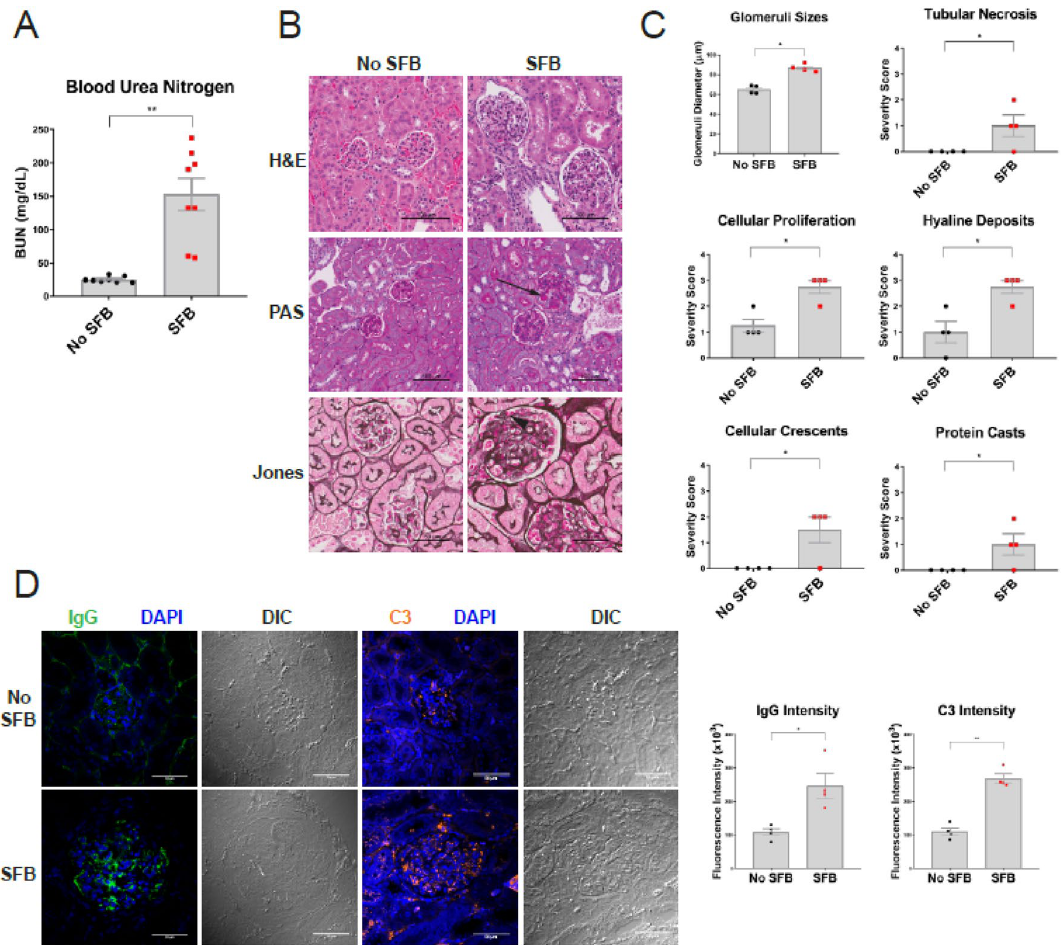
Figure 1. NZM2410 colonized with SFB exhibit intensified kidney disease with elevated immune-complex deposition. 10-week old mice were oral gavaged with fecal matter from mice harboring SFB or control mice and sacrificed at 30-weeks of age and subjected to biochemical analysis. ( A ) Serum blood urea nitrogen (BUN). ( B ) Kidney disease was directly assessed by performing hematoxylin & eosin (H&E), periodic acid-Schiff (PAS) and Jones’ silver stains. H&E, PAS and silver stain highlight enlarged glomeruli, hyaline deposits (black arrow) and subendothelial deposits (black arrowhead) in SFB colonized mice, respectively. ( C ) Histopathological assessment of kidney tissue was blindly scored by a veterinary pathologist; kidney pathology was defined as tubular necrosis, cellular proliferation, hyaline deposits, cellular crescents and protein casts. ( D ) Immunofluorescence staining of IgG and C3 deposition in the glomerular and tubulointerstitium of kidney tissue; differential interference contrast (DIC) also shown. Error bars represent mean ± SEM ( A , C , D ).